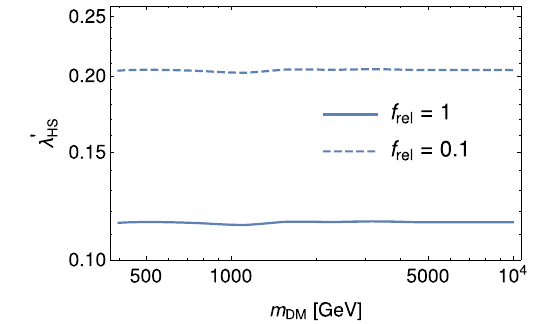
Fig. 11 Limits from the direct-detection experiments for the coupling λ (cid:3) asafunctionoftheDMmassfortheHiggs-mediatorportalscenario HS withfermionicDMandamassoftheheavyscalareigenstateof400GeV. The solid (dashed) line corresponds to f rel = 1 ( f rel = 0 . 1)